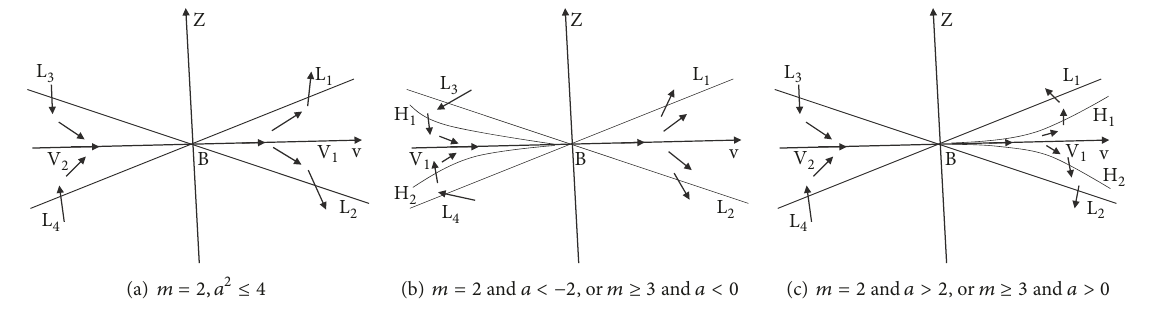
Figure 3: The qualitative properties of (0,0) of the system